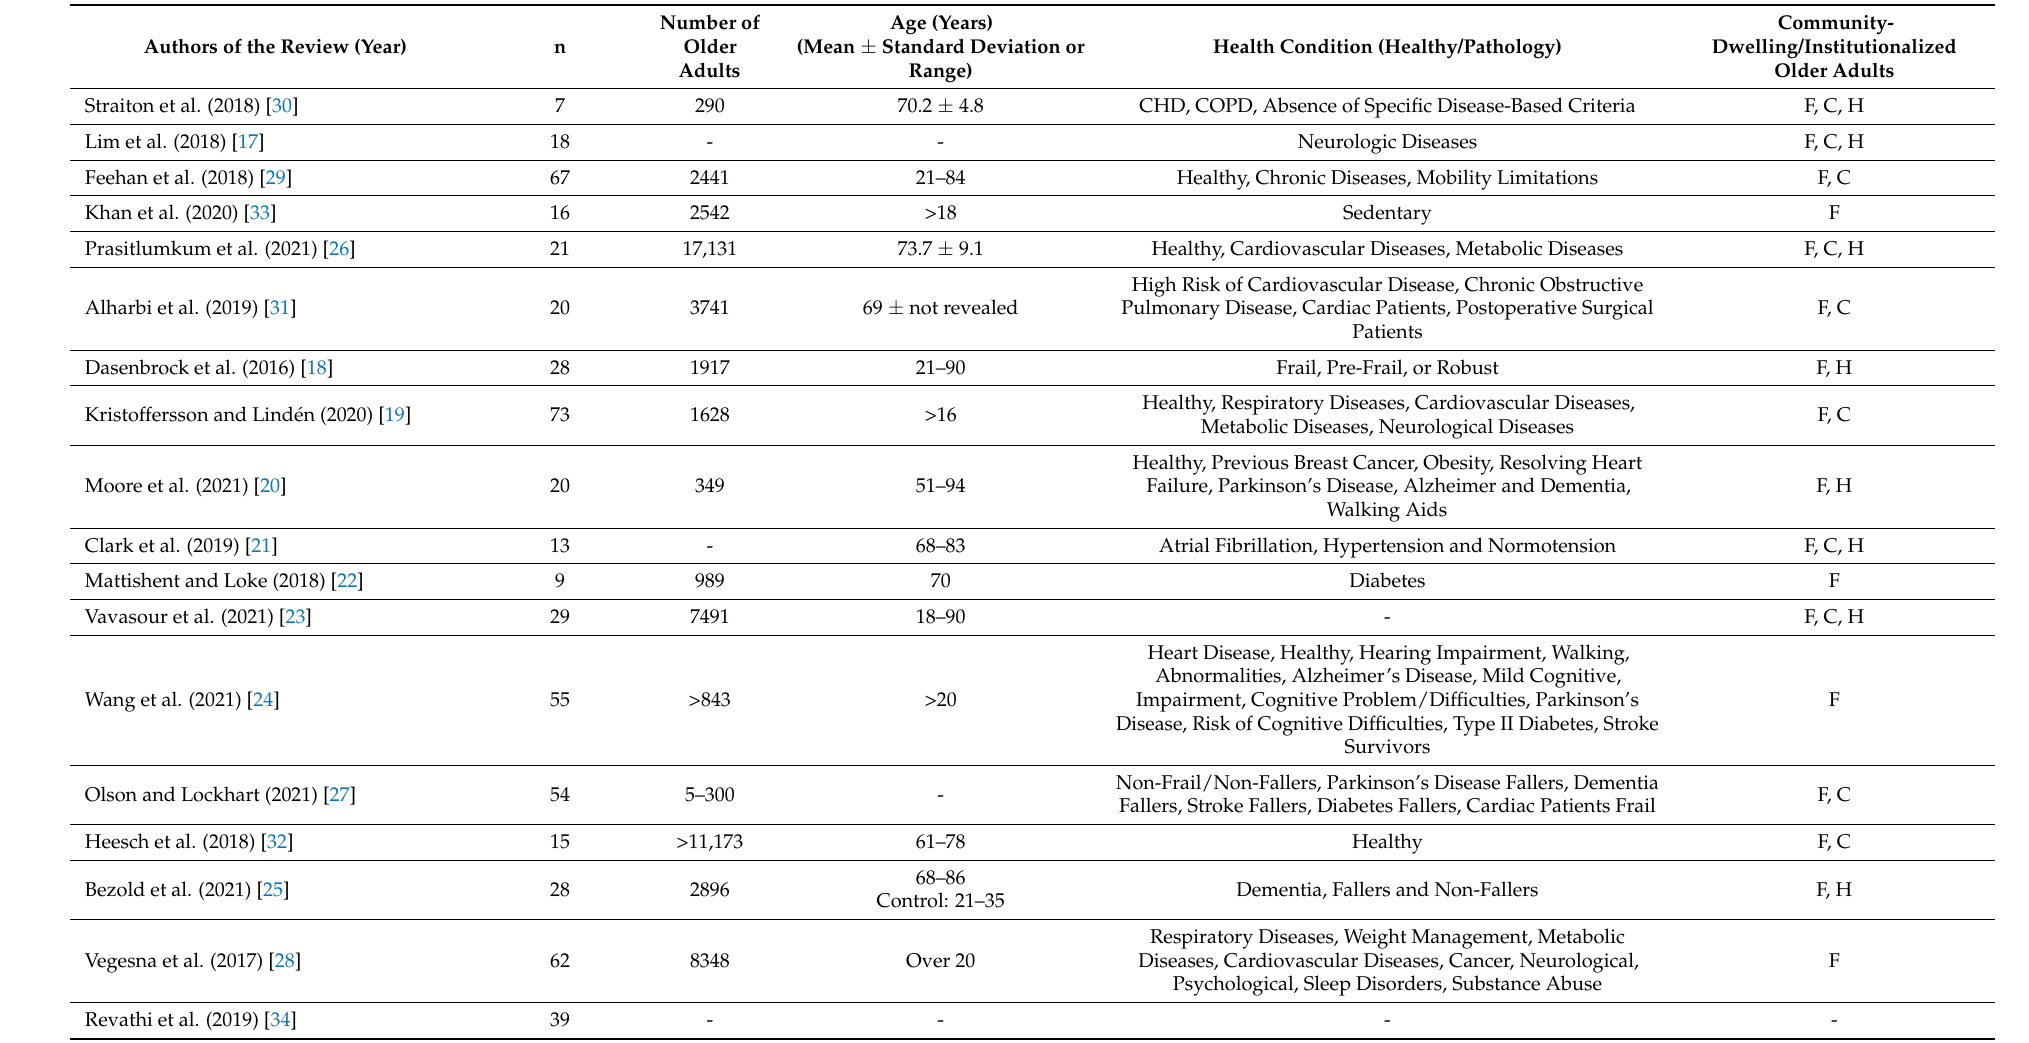
Table 3. Characteristics of the studies’